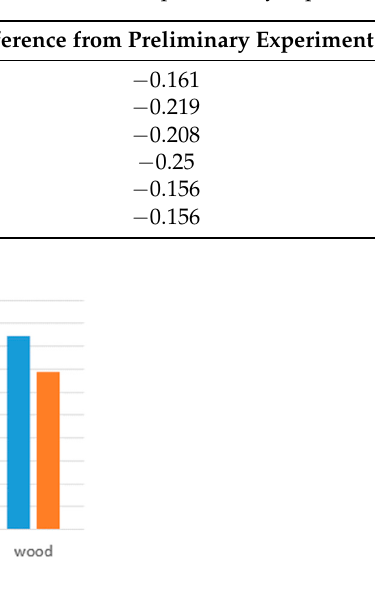
Table 9. Accuracy of each material class and difference between main and preliminary experiments.